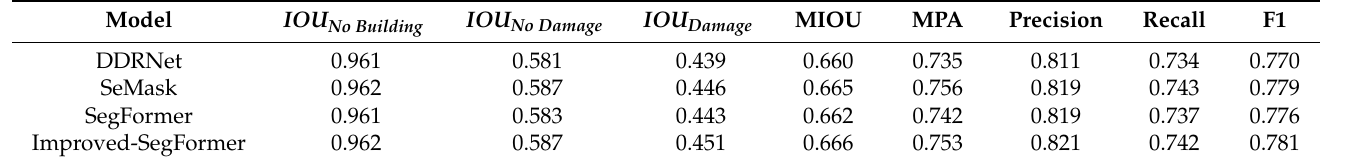
Table 3. Relevant evaluation indexes of SegFormer and Improved-SegFormer on building damage. Model